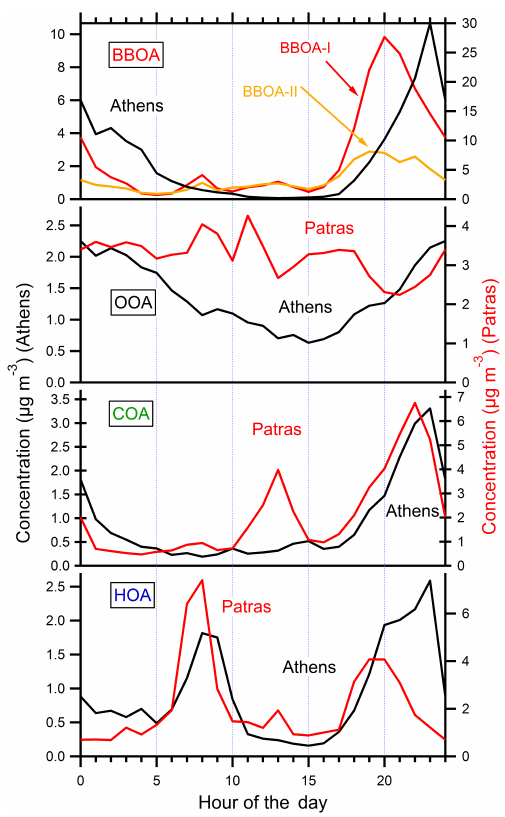
Figure 9. Diurnal profiles of the PMF factors in Athens (black) and Patras (red-yellow). On the left y axis are the concentrations of Athens’ PMF factors, while on the right y axis are those of Pa-